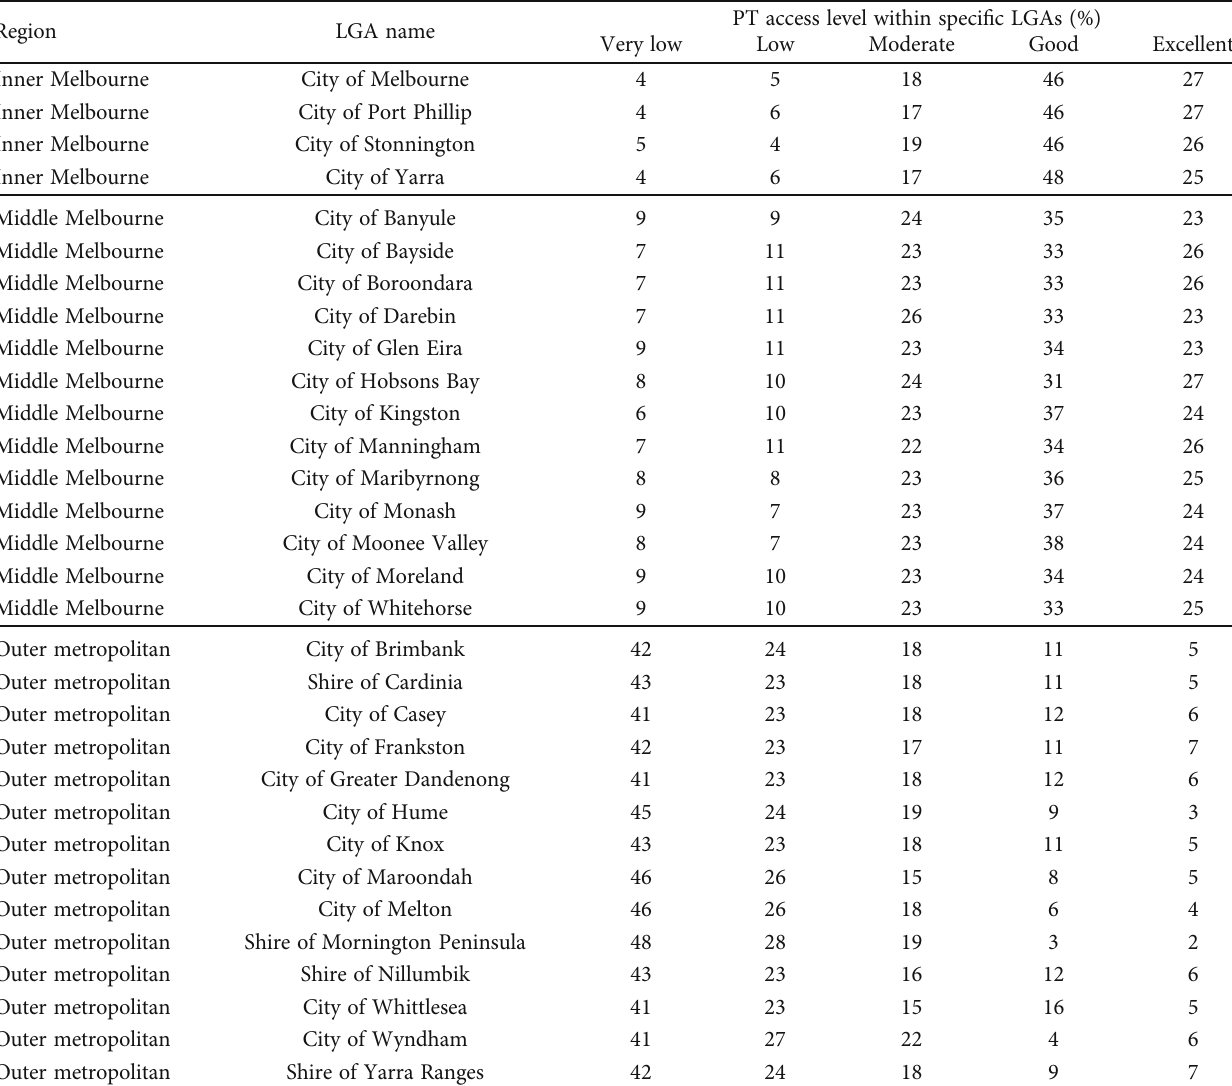
Table 10: Summary of Melbourne LGAs ’ older peoples ’ PT accessibility